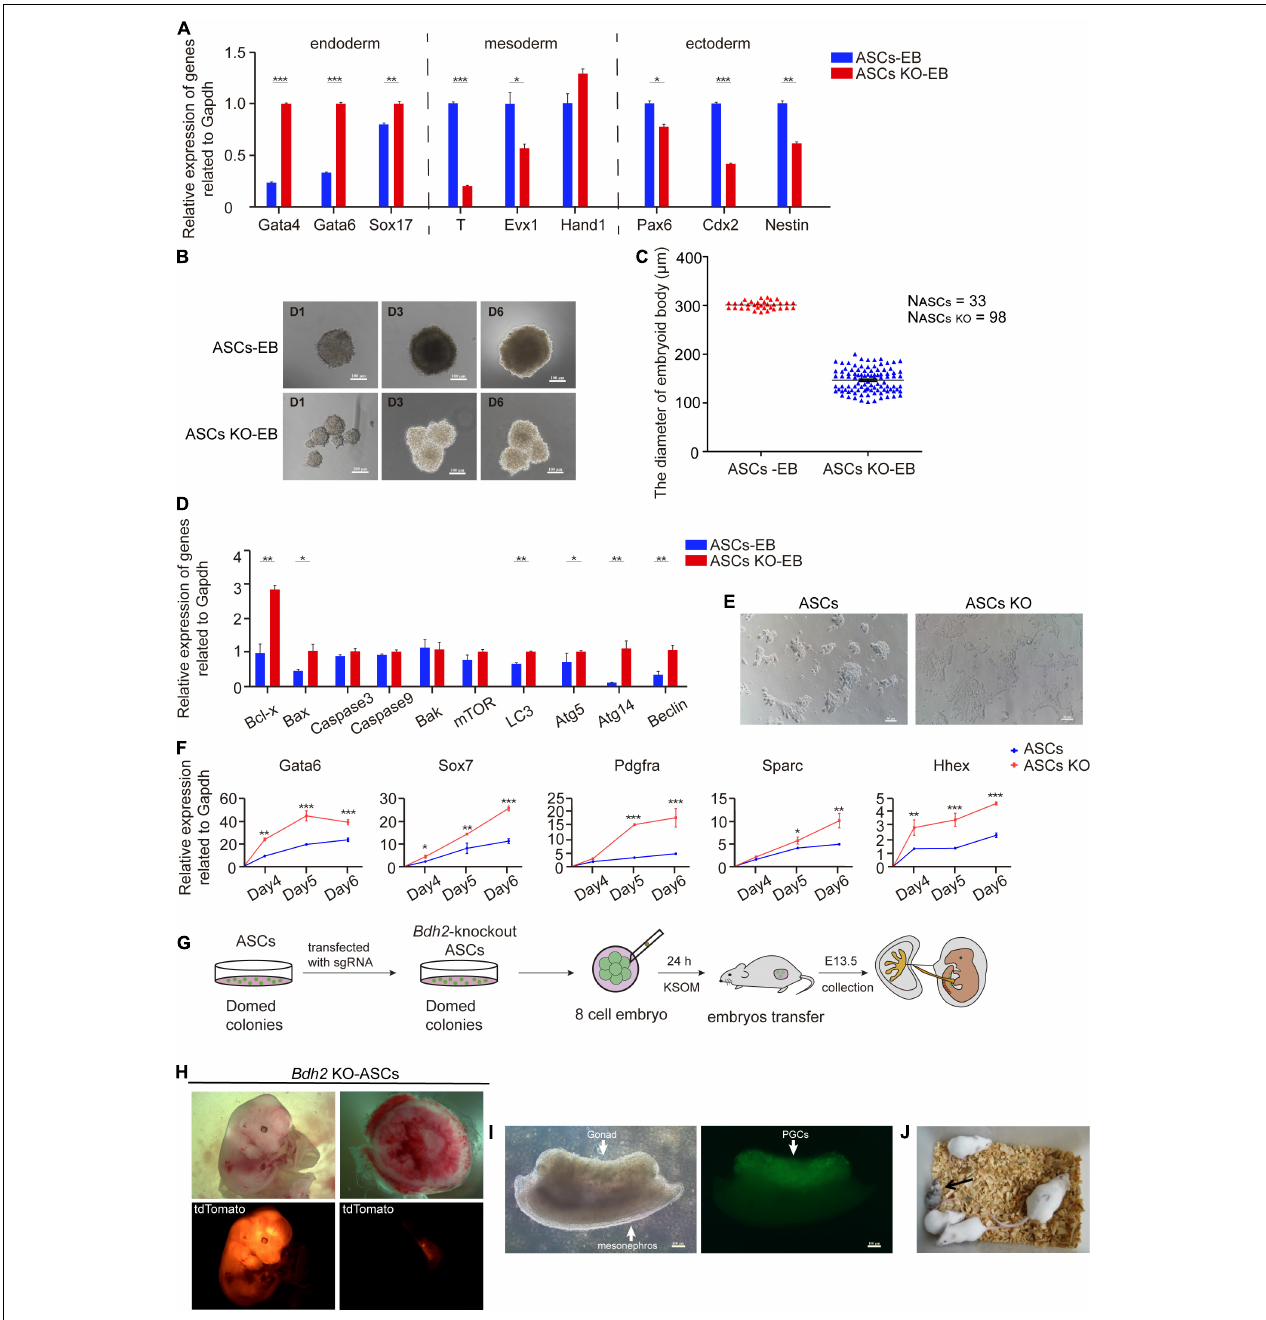
FIGURE 5 | Differentiated and developmental potency of Bdh2 -knockout ASCs. (A) Real-time PCR analysis of endoderm, mesoderm and ectoderm-associated genes expression in the embryoid bodies of Bdh2 -knockout ASCs, embryoid bodies of ASCs were used as control. Data were obtained in triplicate and presented as mean ± SD. p -values were calculated by two-way ANOVA, * p < 0.05, ** p < 0.001, *** p < 0.0001. (B) Morphology of embryoid bodies induction by Bdh2 -knockout ASCs and ASCs in Day1, Day3, and Day6. Scale bars, 100 µ m. (C) Statistics of the number and diameter of embryoid bodies formed by Bdh2 -knockout ASCs and ASCs, respectively. N, represents the number of EB spheres. (D) Real-time PCR analysis of apoptotic and autophagy-associated genes expression in the embryoid bodies of Bdh2 -knockout ASCs, embryoid bodies of ASCs were used as control. Data were obtained in triplicate and presented as mean ± SD. p -values were calculated by two-way ANOVA, * p < 0.05, ** p < 0.001, *** p < 0.0001. (E) Representative bright-field images from Bdh2 -knockout ASCs and ASCs differentiated for 5 days toward the primitive endoderm lineage. Scale bars, 50 µ m. (F) Real-time PCR analysis of key markers after 4/5/6 days of directed differentiation toward primitive endoderm. Data were obtained in triplicate and presented as mean ± SD. p -values were calculated by two-way ANOVA, * p < 0.05, ** p < 0.001, *** p < 0.0001. (G) Schematic illustrating chimera production from Bdh2 -knockout ASCs. (H) Chimeras (E13.5) generated with Bdh2 -knockout ASCs (multiple cells). ASCs carried tdTomato + /GOF + reporter. (I) Germline transmission of Bdh2 -knockout ASCs in E13.5 chimeras. PGCs were shown by GOF/GFP + cells (arrow). Scale bars, 100 µ m. (J) A chimeric pup generated by injecting 15 ∼ 20 Bdh2 -knockout ASCs in ICR host blastocysts.